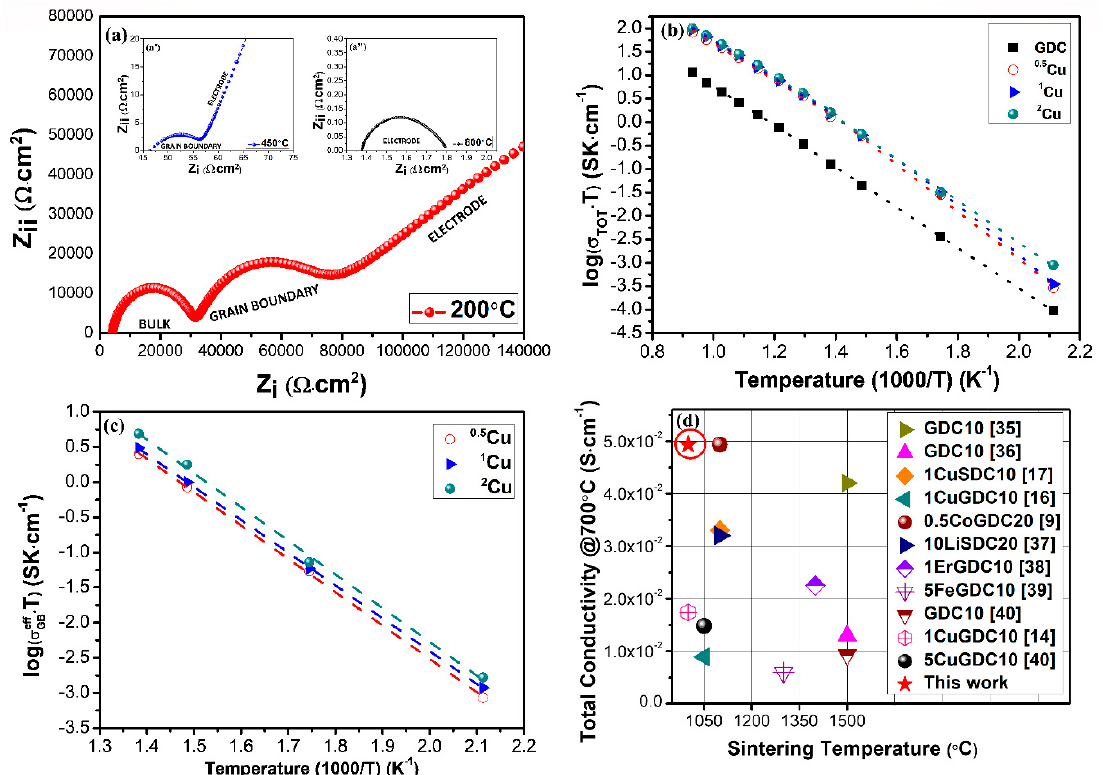
Figure 7. ( a ) Nyquist plots at several temperatures, ( b ) Arrhenius plot of total conductivity, ( c ) Arrhenius plot of grain boundary conductivity, and ( d ) comparison with literature. Table 4. Total conductivities and activation